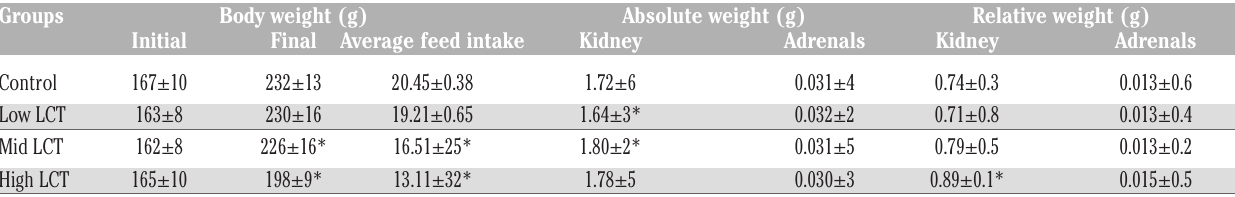
Table 1. Effect of three doses of lambda-cyhalothrin (20.4, 30.6 and 61.2 mg/kg b.w.) on initial and final body weights, average feed intake, and kidney and adrenal-gland weights.